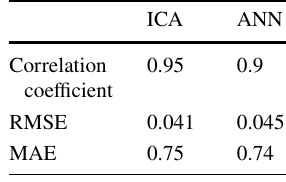
Fig. 13 Comparison of down- stream water needs with the obtained values by ICA and